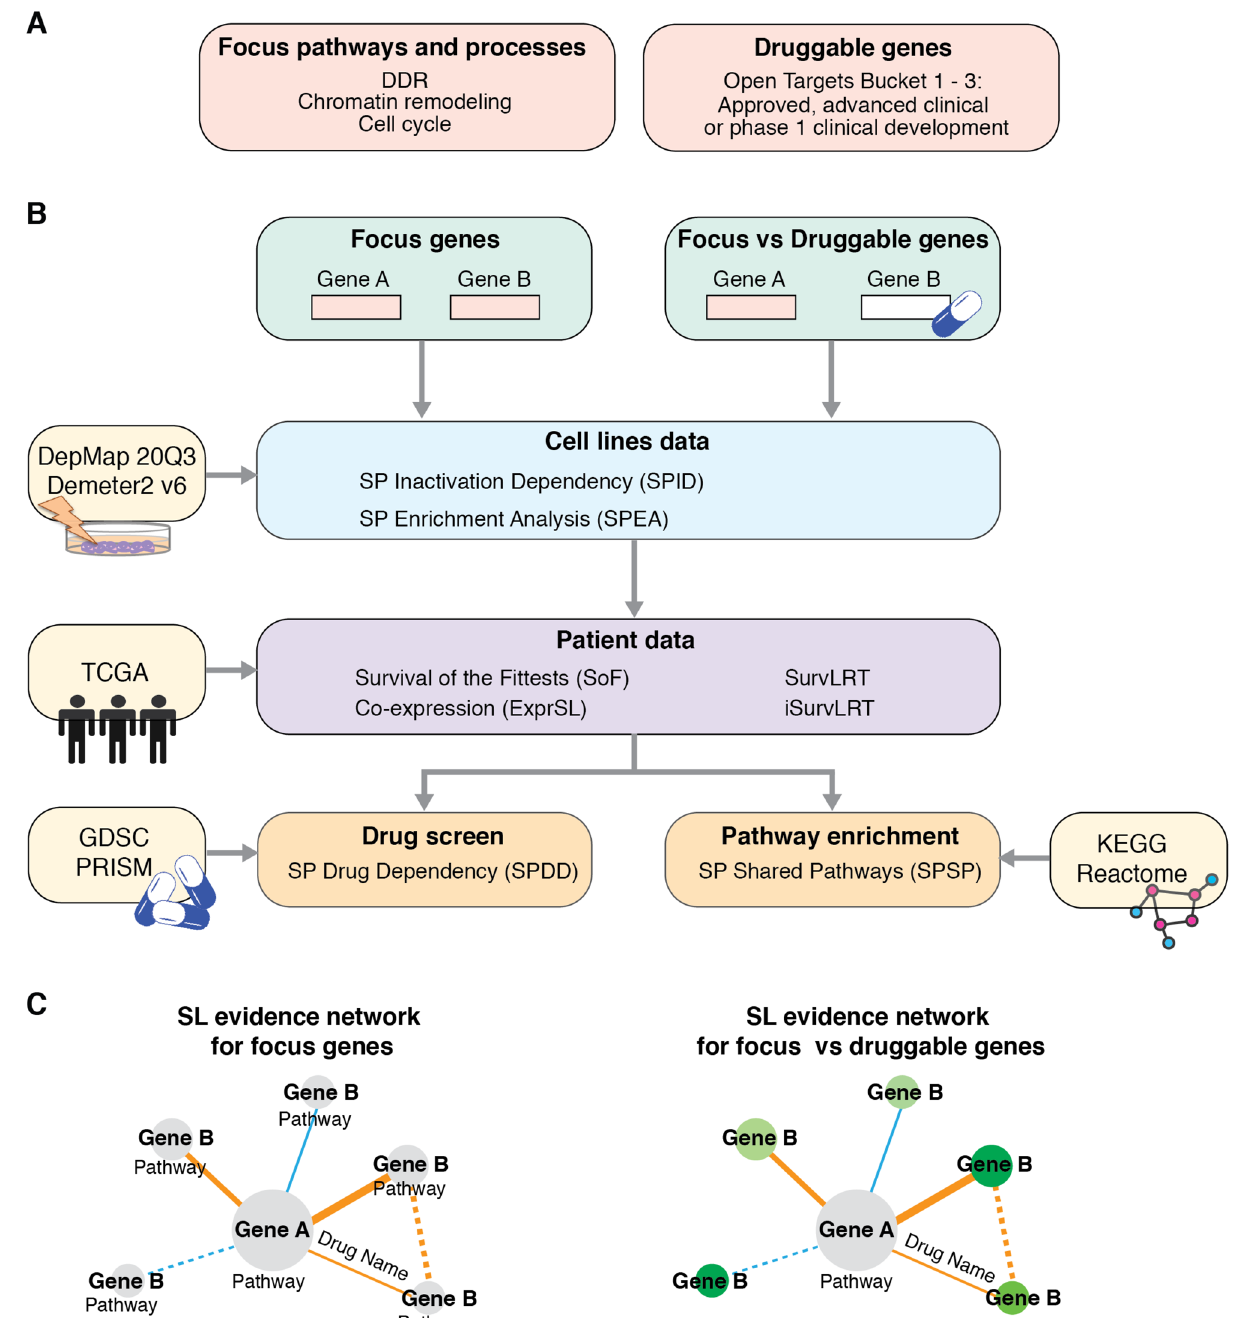
Figure 1. Synthetic lethal partners identification workflow used in SLIDE-VIP. ( A ) The focus genes were defined based on their involvement in one of the focus pathways and processes, and druggable genes were selected from the Open Target database (Bucket 1–3). ( B ) The two input sets of gene pairs (focus genes and focus vs druggable genes) were first tested in cell line data (DepMap20Q3 and Demeter2 v6), and then filtered using statistical analysis of patient data (TCGA). Additional evidence of SL interactions was gather using drug screen validation (GDSC and PRISM) and pathway enrichment (KEGG and Reactome). The arrows represent each step in the workflow. ( C ) The results were utilized to create SL evidence networks summarizing the evidence from all tests. Each node represents a gene (gene A or B) and the node size indicates the number of gene partners. The edge width symbolizes the number of overlapping pathways between two genes with a solid line showing the confirmation from at least two tests from patient data. The grey nodes symbolize focus genes and for them pathways in which a gene is involved are shown below the gene name. The green shaded nodes illustrates the druggable genes and the drug development stage (dark green approved, light green advanced clinical and yellow phase 1 clinical development stage). GDSC the Genomics of Drug Sensitivity in Cancer; KEGG Kyoto Encyclopedia of Genes and Genomes; PRISM Profiling Relative Inhibition Simultaneously in Mixtures; SL synthetic lethality; SP synthetic partner; TCGA The Cancer Genome